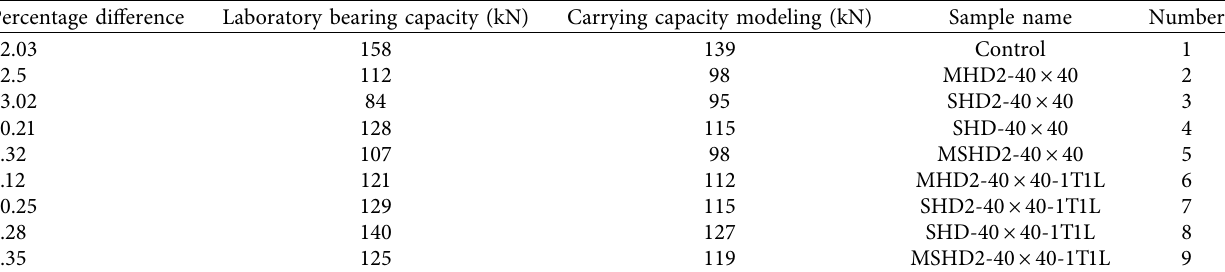
Figure 12: Comparison of force-displacement diagram of laboratory samples. Table 6: Specifications of laboratory samples and modeling